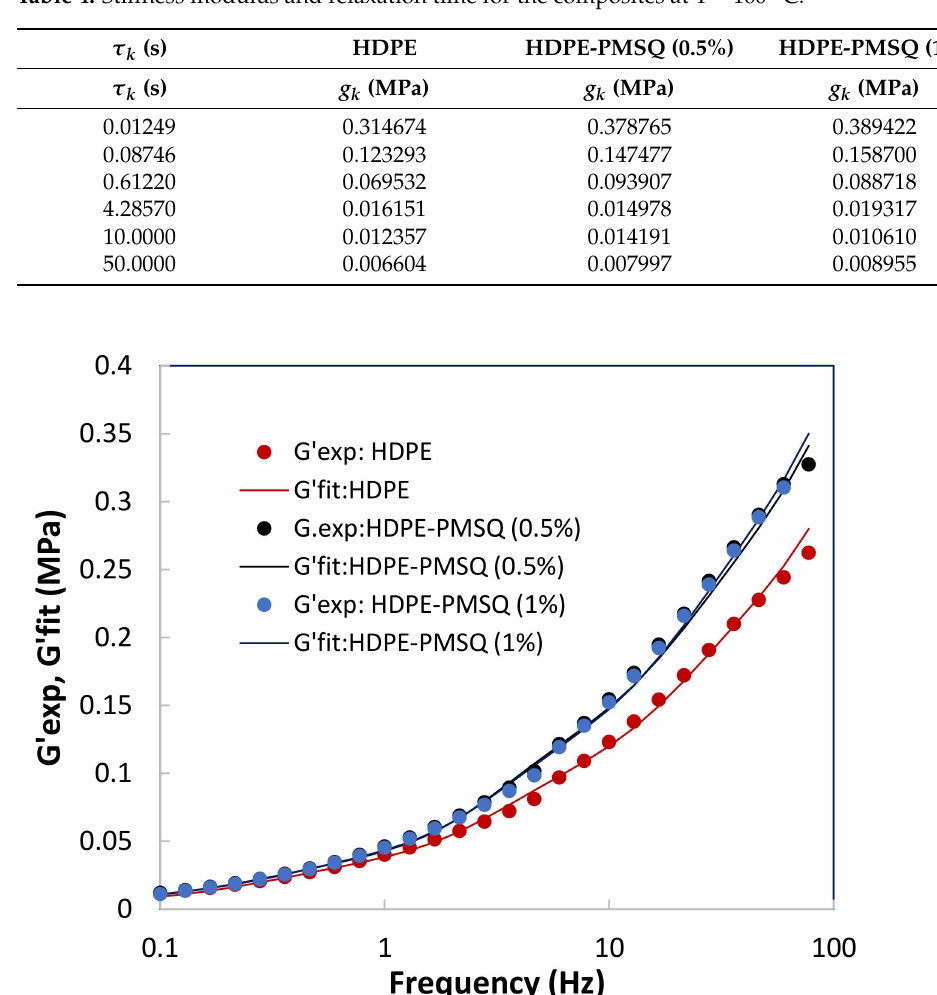
Figure 4. Results of the optimization with the experimental storage moduli G (cid:48) as a function of the PMSQ nanoparticles